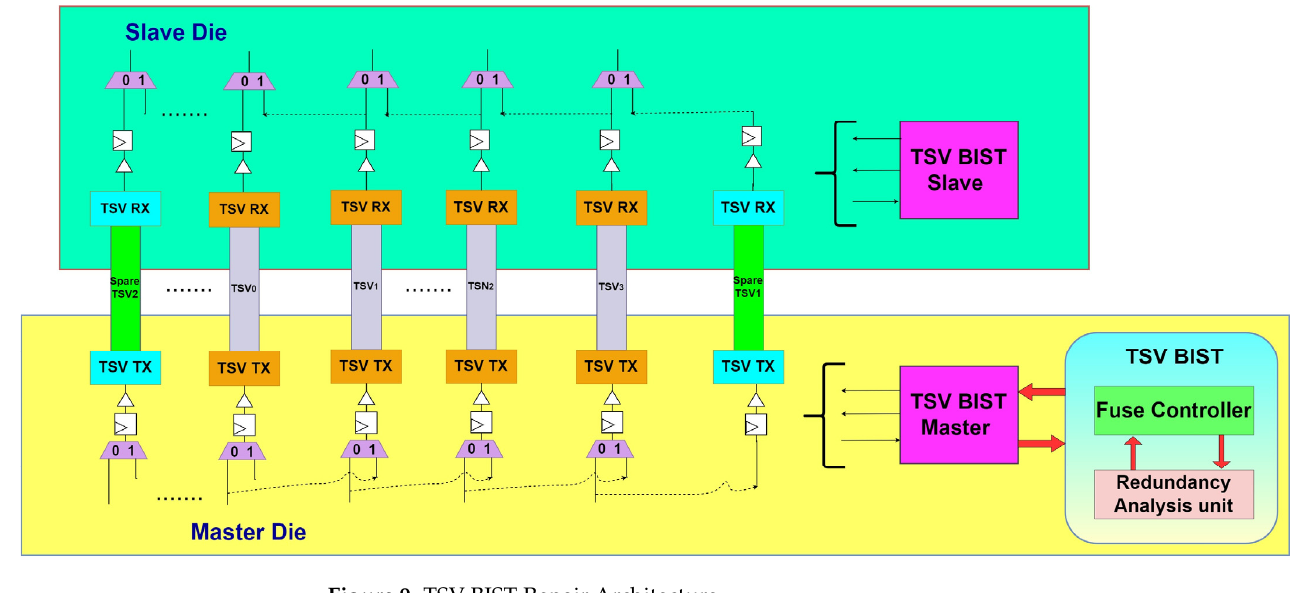
Figure 9. TSV BIST Repair Architecture.